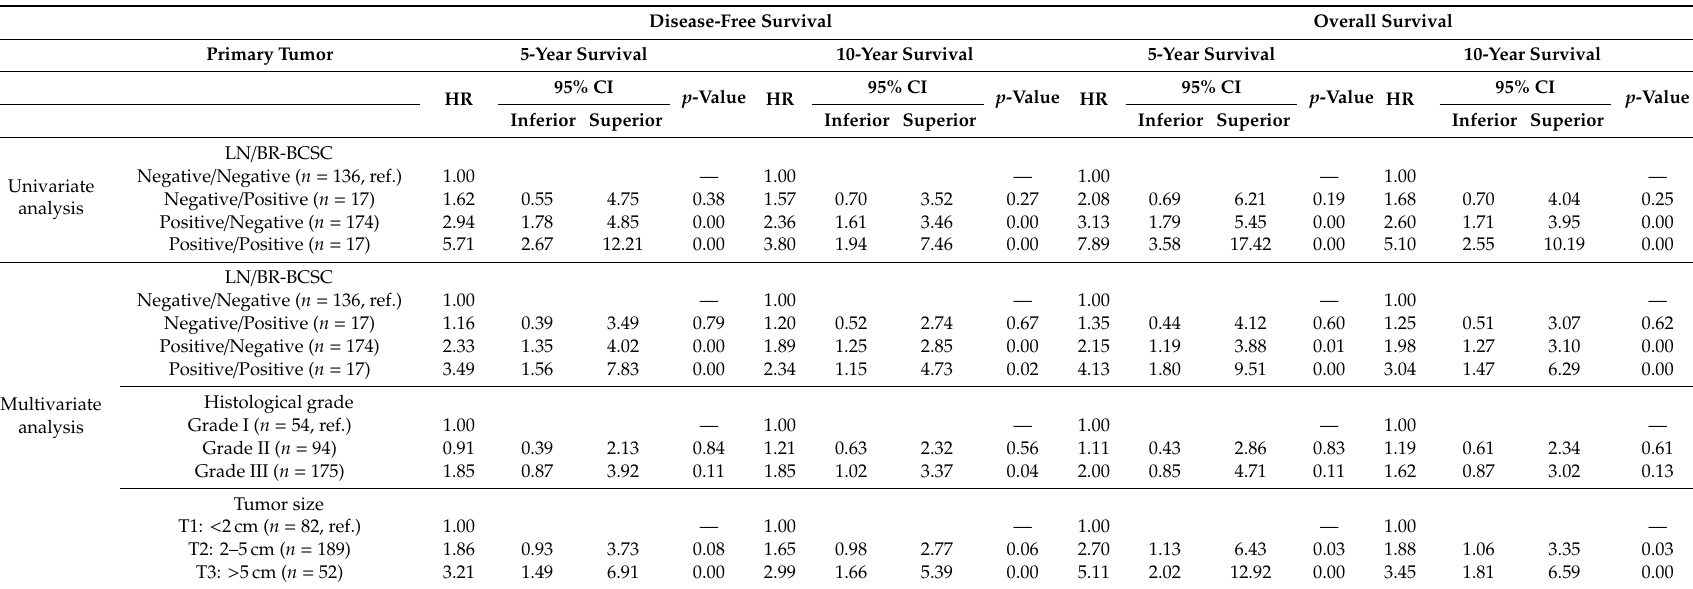
Table 3. Univariate and multivariate Cox proportional hazard analysis for the lymph-node (LN) status and BR-BCSC signature in the primary carcinomas. This analysis allows risk prediction (hazard ratios and the corresponding 95% confidence interval) for DFS and OS of breast cancer patients, in the primary tumor series. A significant level of 5% was considered. Missing cases were not considered for statistical analysis. The multivariate Cox regression analysis included the e ff ects of histological grade and tumor